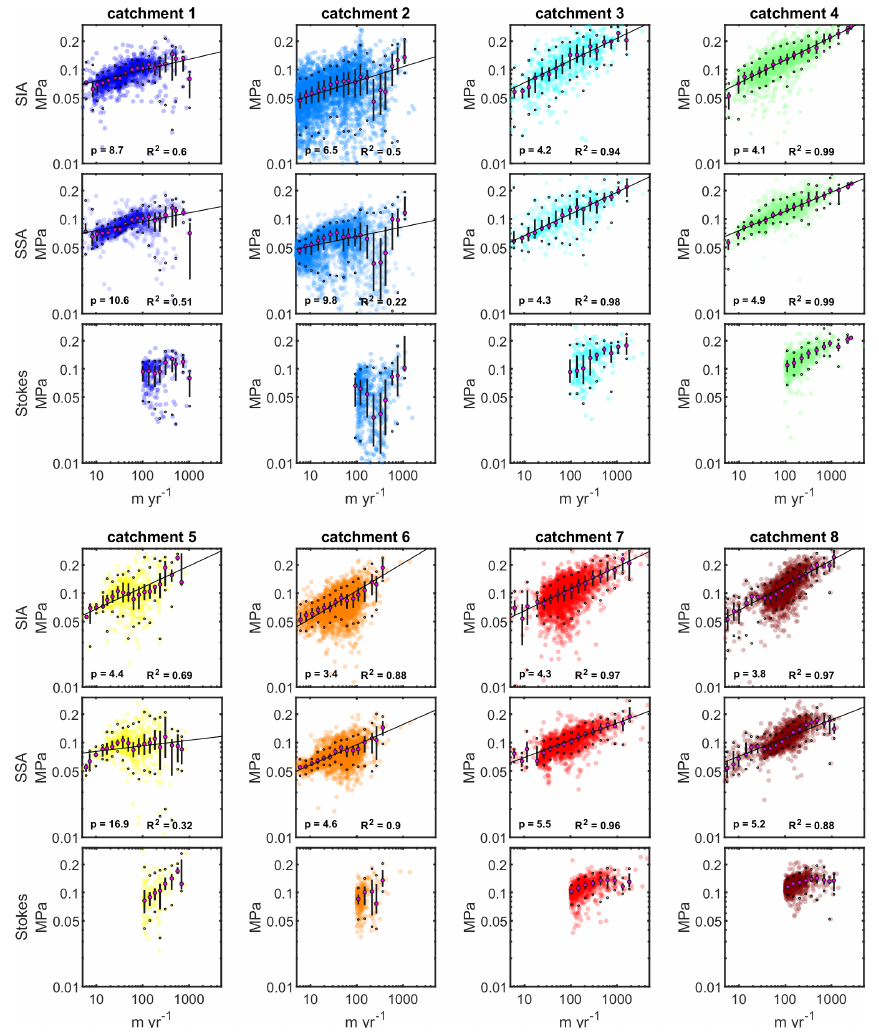
Figure 4. The velocity–traction relationship for the SIA, SSA, and full-Stokes inversions for all eight drainage catchments. Transparency is an indicator of data density, where opaque areas indicate four or more grid cells occupy the same marker area on the plot. Magenta markers show the median traction values for 20 logarithmically spaced velocity bins; the vertical bars show the interquartile range; and the black dots indicate the middle 90th percentile of the data. Black line shows a power-law model fit to the binned data. No models were fit to the Stokes relationships due to the velocity range ( > 100myr − 1 ) which is limited in our